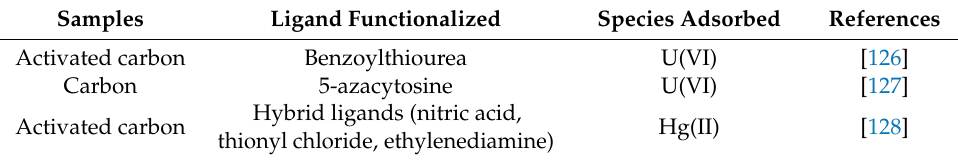
Table 6. Ligand functionalization of activated carbons and their